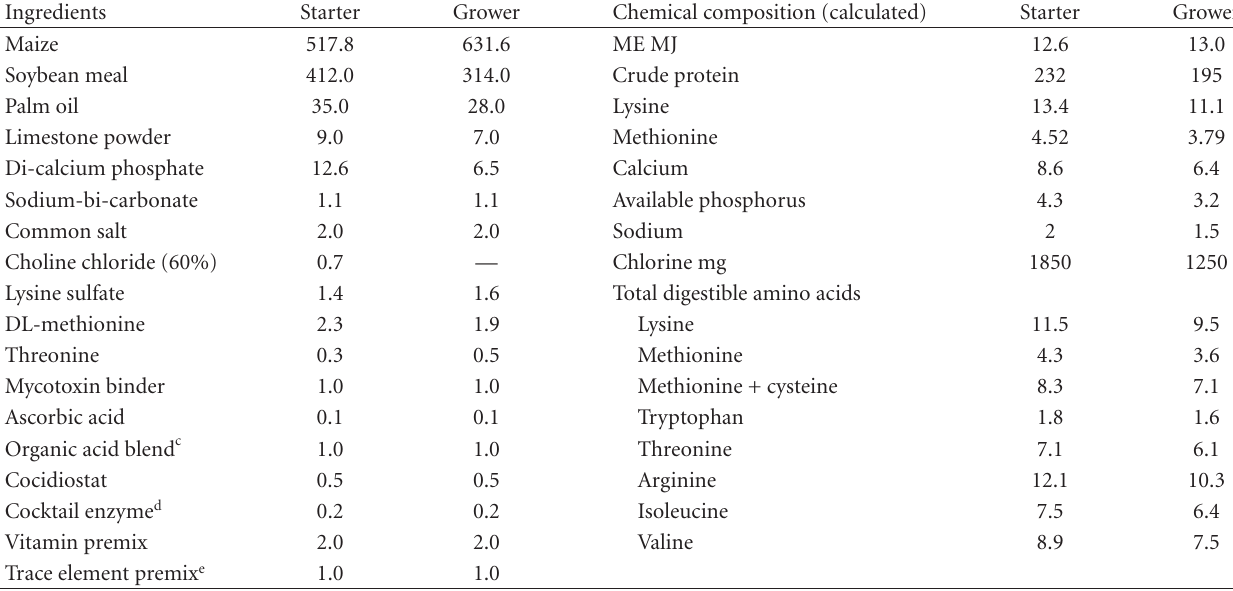
Table 1: Ingredients and chemical composition of the basal diet (g/kg as fed, unless stated other wise) a,b